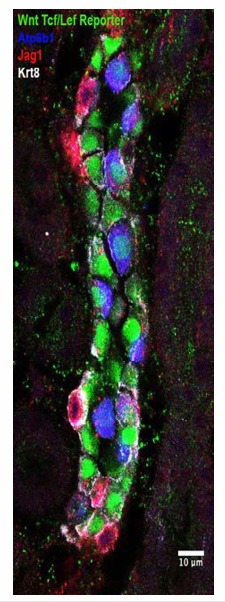
DOI:
http://dx.doi.org/10.7554/eLife.24265.030